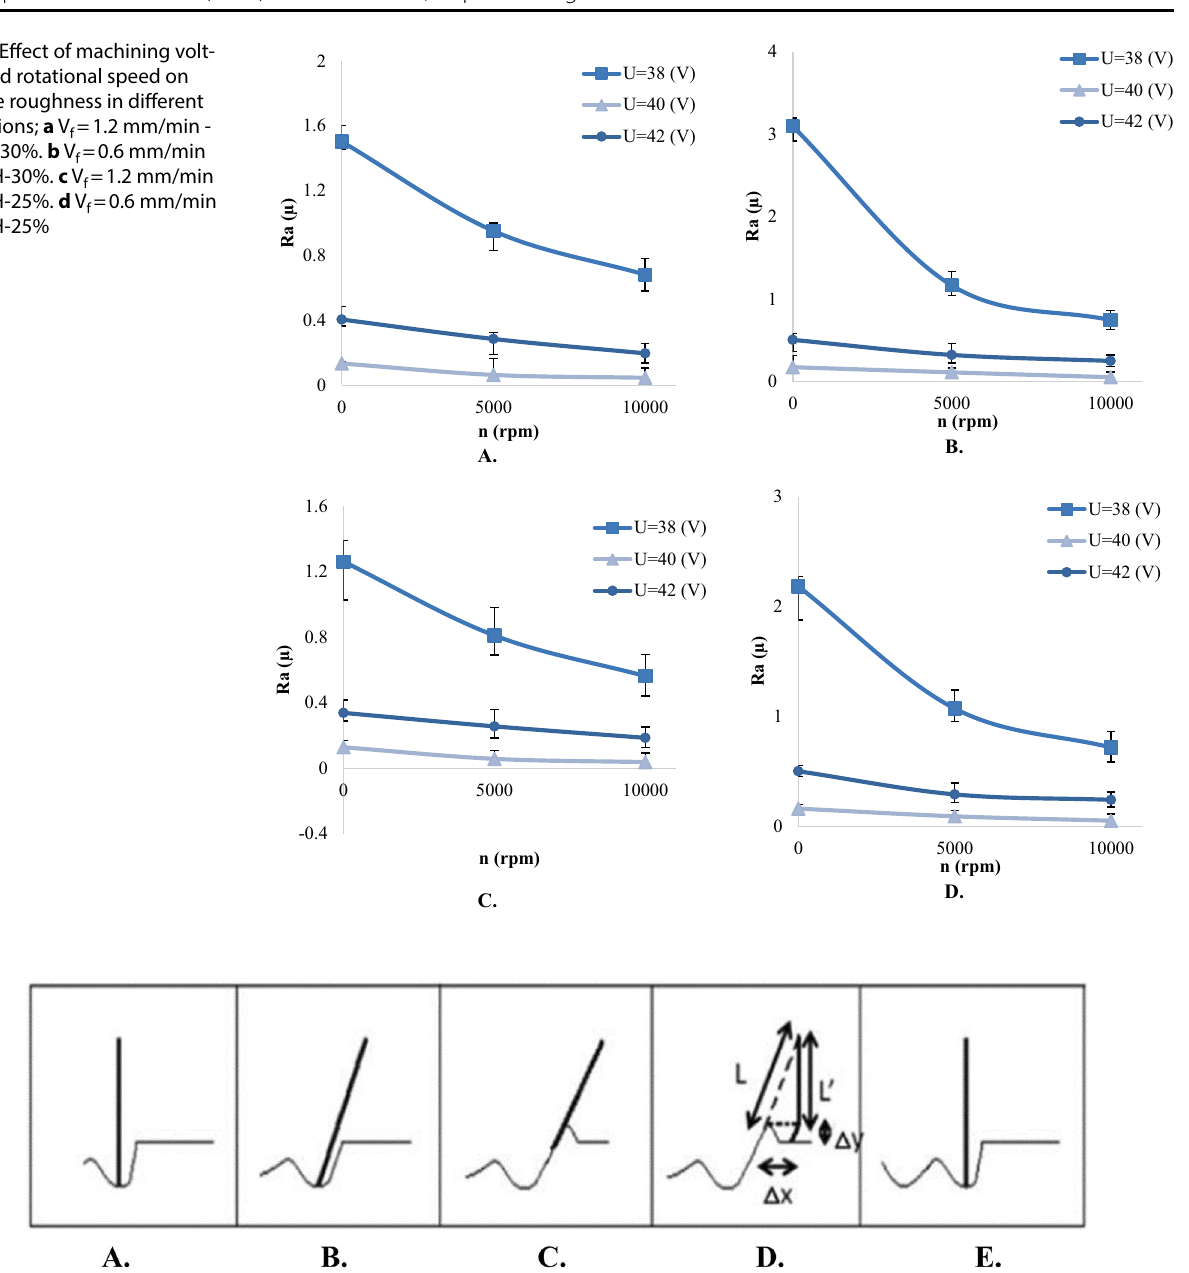
tool to piece, c Sticking and separation of tool from workpiece sur- face, d Bending and jumping of piece to another place, e Forma- tion of another